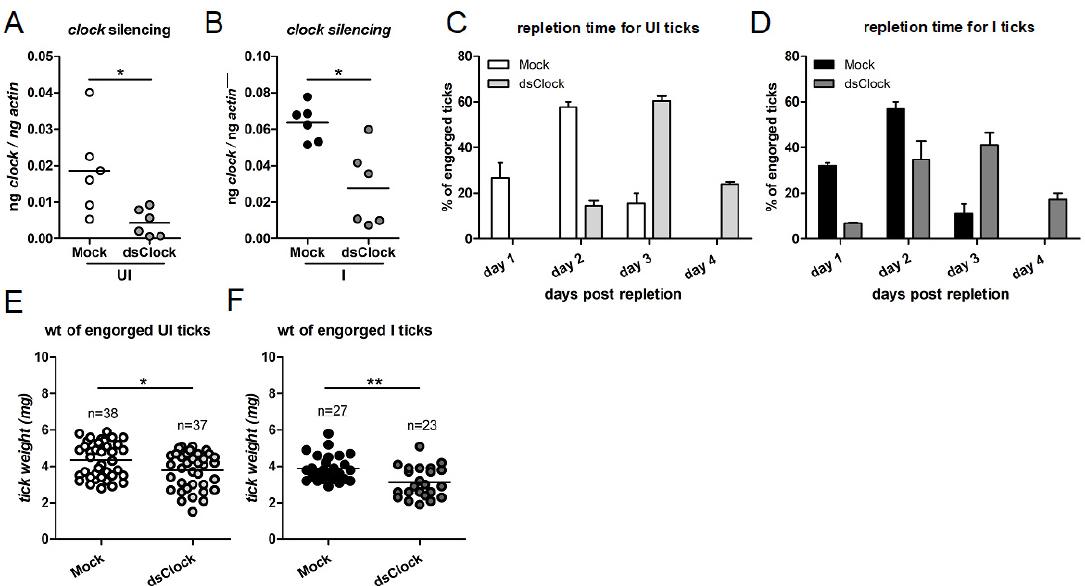
Figure 6. RNAi-mediated silencing of tick clock gene expression affects tick engorgement and delays feeding time on the murine host. QRT-PCR analysis showing levels of clock transcripts in mock- dsRNA-injected or clock -dsRNA-injected uninfected ( A ); or A. phagocytophilum -infected ( B ) nymphs fed on naïve mice. Levels of clock transcripts were normalized to tick beta-actin levels. Percentage of mock-dsRNA-injected or clock -dsRNA-injected uninfected ( C ); or A. phagocytophilum -infected ( D ) tick repletion after 72 h post tick placement is shown. Days 1, 2, 3, 4 represents 72, 84, 96 and 108 h post tick placement time points. Engorgement weights of mock-dsRNA-injected or clock -dsRNA- injected uninfected ( E ); or A. phagocytophilum -infected ( F ) ticks are shown. Each circle represents one tick. Statistical analysis was performed using Student’s t -test, and a p -value of less than 0.05 was considered significant. * p < 0.05, ** p < 0.01.